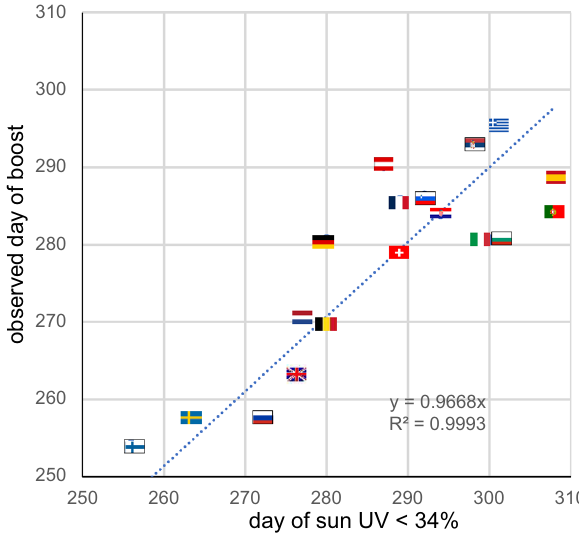
Figure 5. Observed day of the second COVID-19 wave surge as a function of the day when the country sun UVB daily dose drops lower than 34% of that at latitude 0°. Trendline forced to intercept